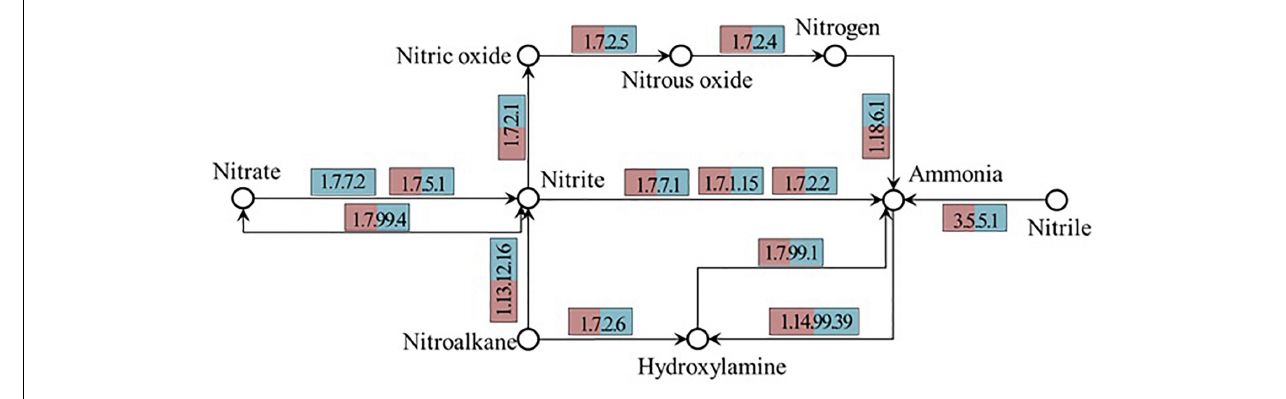
FIGURE 6 | Nitrogen cycle related key enzymes along the DN-DBF depth.